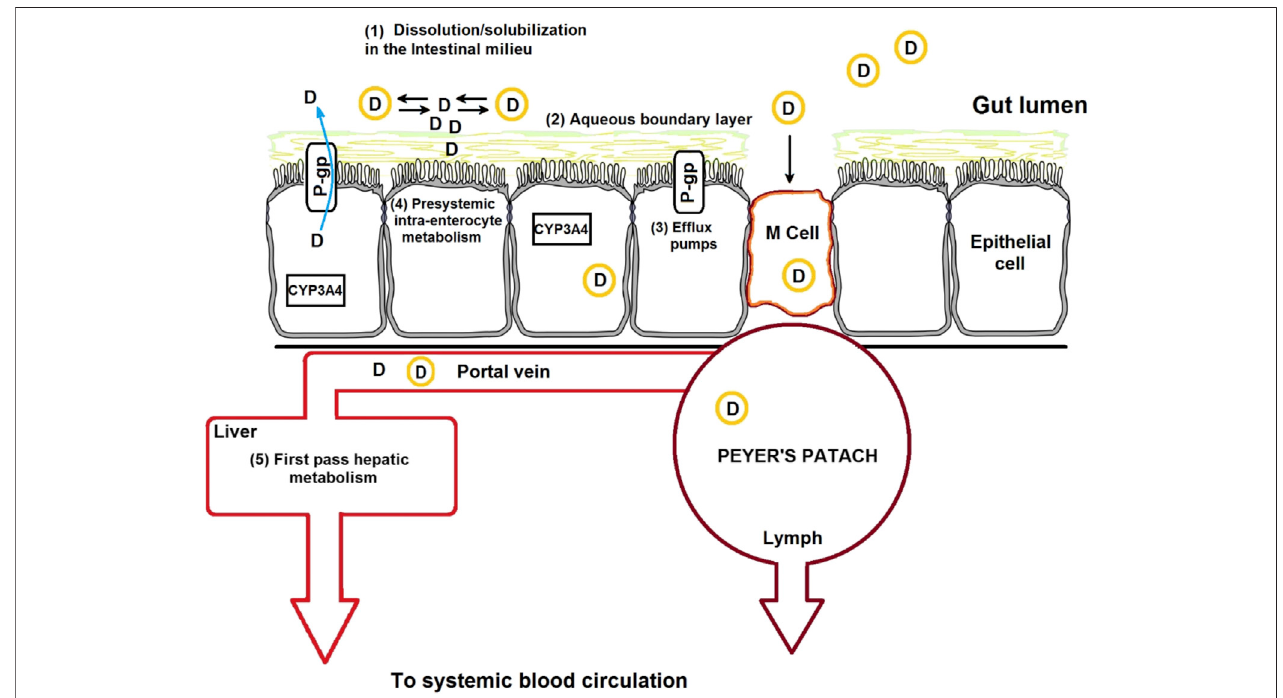
FIGURE 2 | Schematic representation of the drug absorption barriers and mechanisms of nanoparticle transport across the intestinal epithelium, which include transcellular transport, receptor-mediated transport, and M-cell-mediated transport.